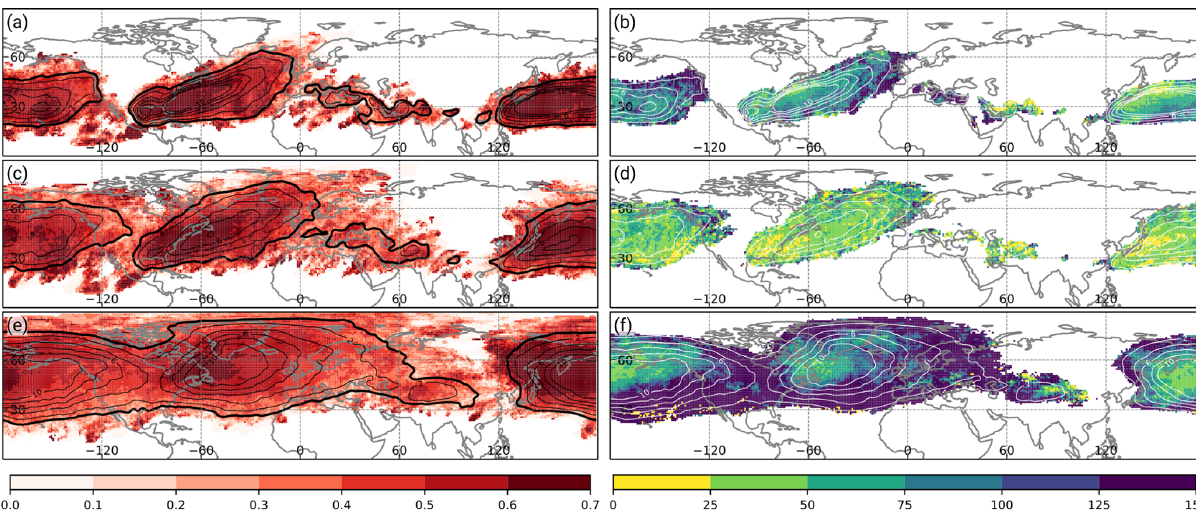
Figure 5. Matthews correlation coefficient of the CNN models during DJF for (a) WCB inflow, (c) WCB ascent, and (e) WCB outflow (shading). Relative difference in terms of the Matthews correlation coefficient between the CNN model and the logistic regression models in Quinting and Grams (2021b) for (b) WCB inflow, (d) WCB ascent, and (f) WCB outflow (shading in %). Relative difference is only shown at grid points for which the climatological Lagrangian WCB frequency reaches at least 1% since the logistic regression models are not available at grid points with a lower climatological frequency. Contours denote the climatological Lagrangian WCB frequency (thick black contour at 1%; thin black and white contours every 2%) for the respective WCB stage. All panels are shown for DJF in the period 1 December 2005 to 29 February